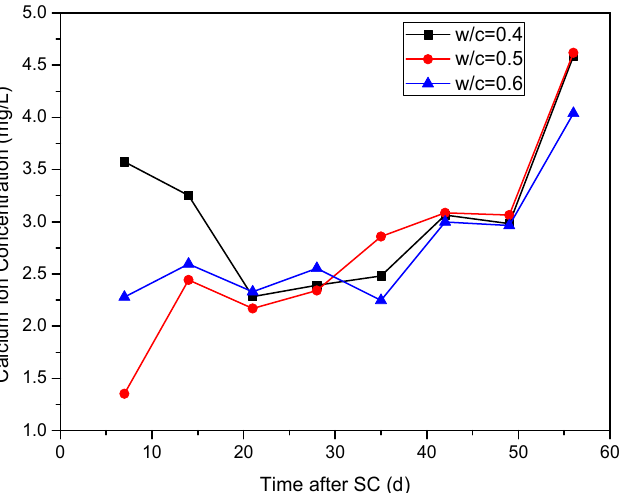
Figure 10. Ca 2+ concentration in the cathode side solution of the specimens with different water- binder ratios.